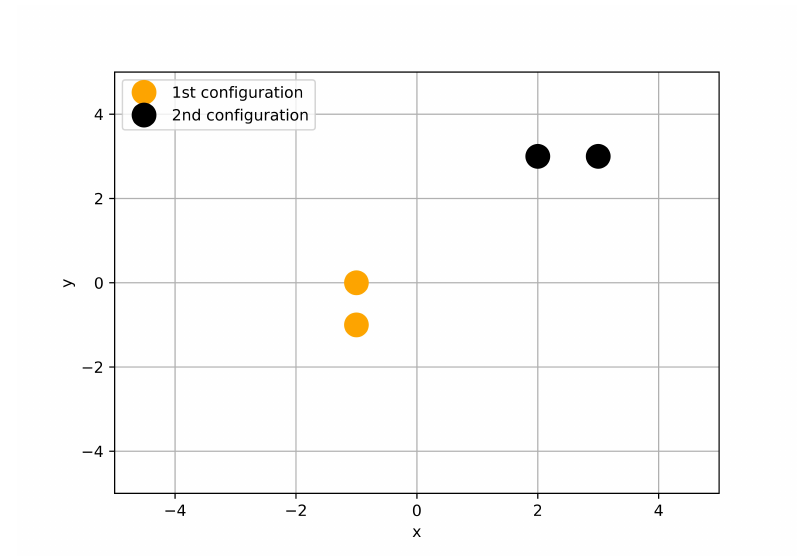
Figure 10. Two different geometric setup of the scattering obstacles.